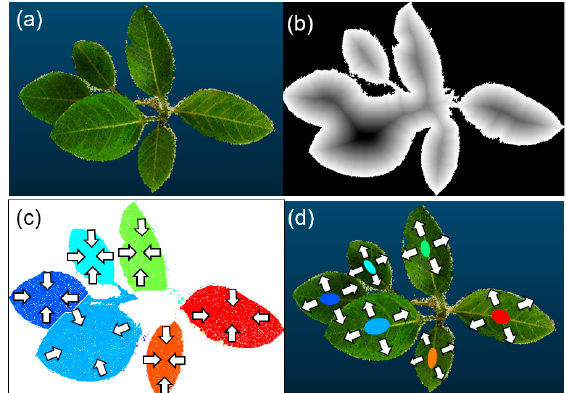
Figure 2. Top-view 2D images of a plant generating initial seed regions for 3D leaf segmentation: ( a ) top-view image of a 3D plant point-cloud image; ( b ) grayscale image via distance transform—the contrast represents the distance from the nearest edges; ( c ) an image after initial segmentation by the watershed algorithm—colors represent each leaf and arrays indicate the directions of shrinking to create seed regions; and ( d ) an image representing seed regions for the 3D leaf segmentation—arrays show the directions for expanding each region in the 3D images.